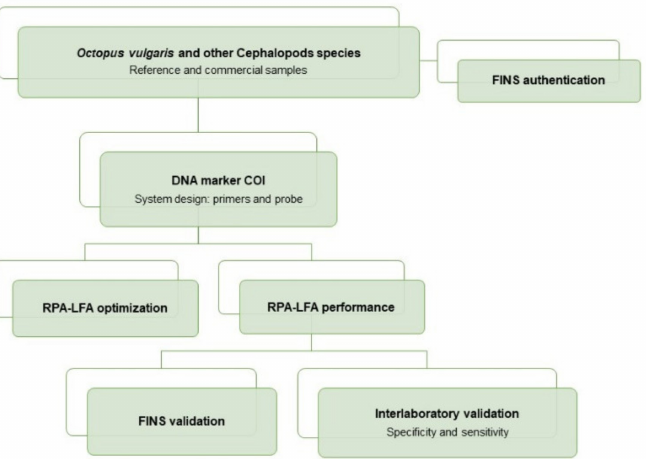
Figure 1. Flow diagram of the experimental procedures used for the development of the RPA-LFA method for the specific detection of Octopus vulgaris in seafood products.